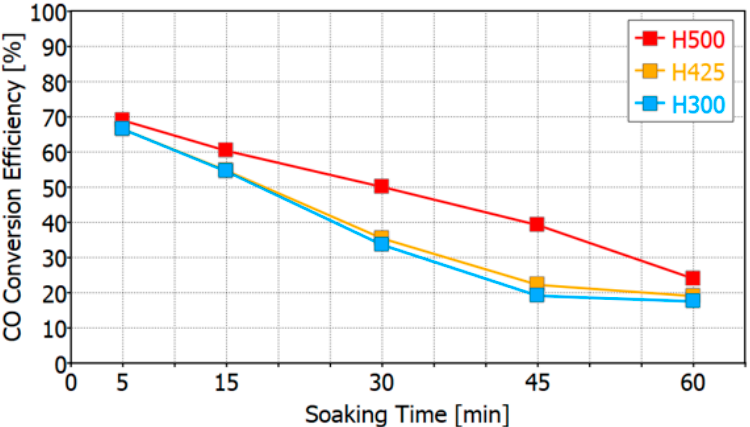
Figure 24. CO conversion efficiency for different PCMs.